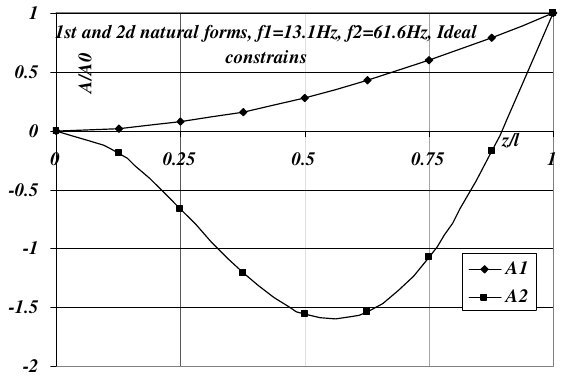
Fig 4. First and second natural forms of vibration